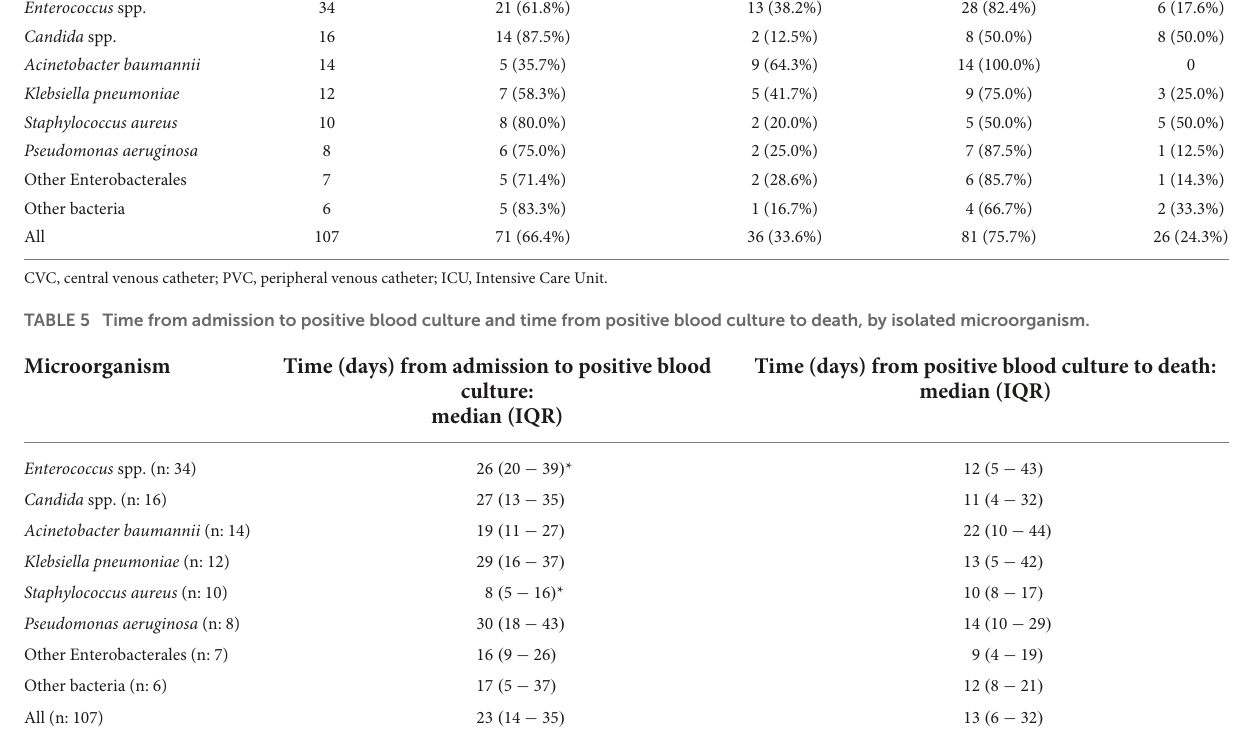
TABLE 4 Microorganisms isolated by source of sample and hospital ward. All Source of sample cultured Hospital ward Peripheral blood CVC or PVC ICU Other Enterococcus spp.